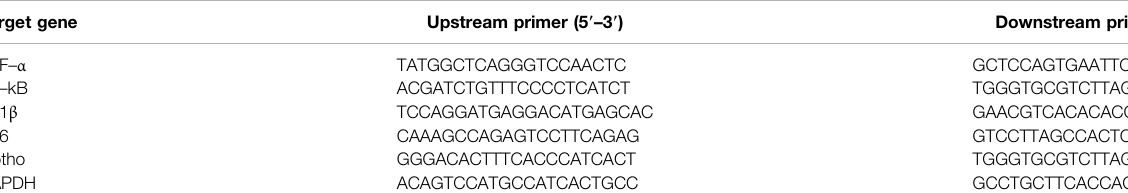
TABLE 1 | qRT-PCR ampli fi cation primer.